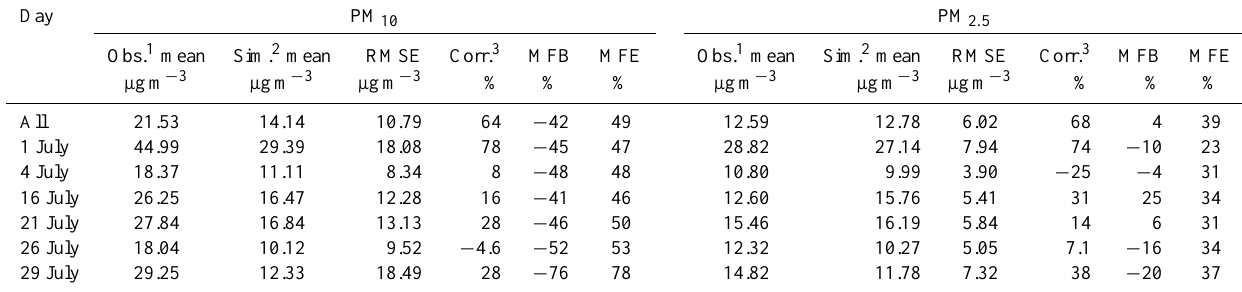
Table 2. Statistics (see Appendix A) of the simulation results for the Airparif network during the MEGAPOLI summer experiment. Day PM 10 PM 2 . 5 Obs. 1 mean Sim. 2 mean All